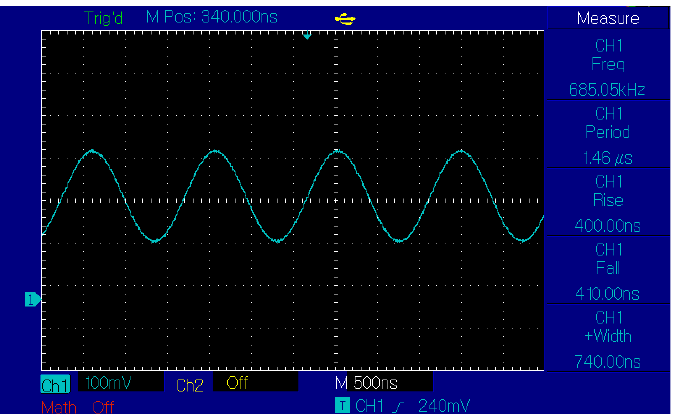
Figure 6. A cosine waveform generated by Cyclone IV FPGA using the RT technique.